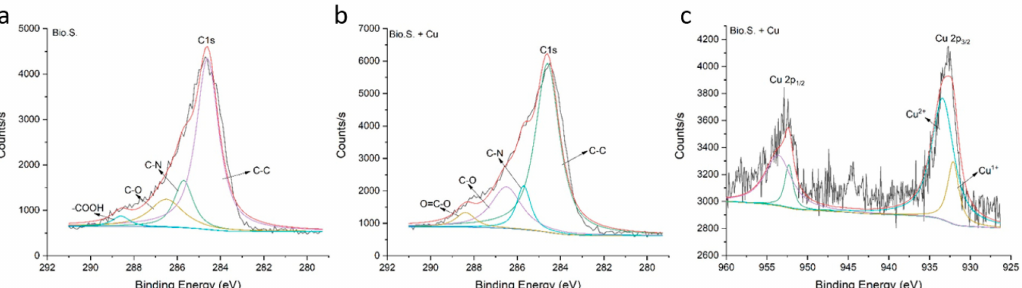
Figure 8. The XPS spectra of C 1s and Cu 2p ( c ) from the surface of BR (Bio.S.) ( a ) and adsorption Cu (Bio.S. + Cu) ( b